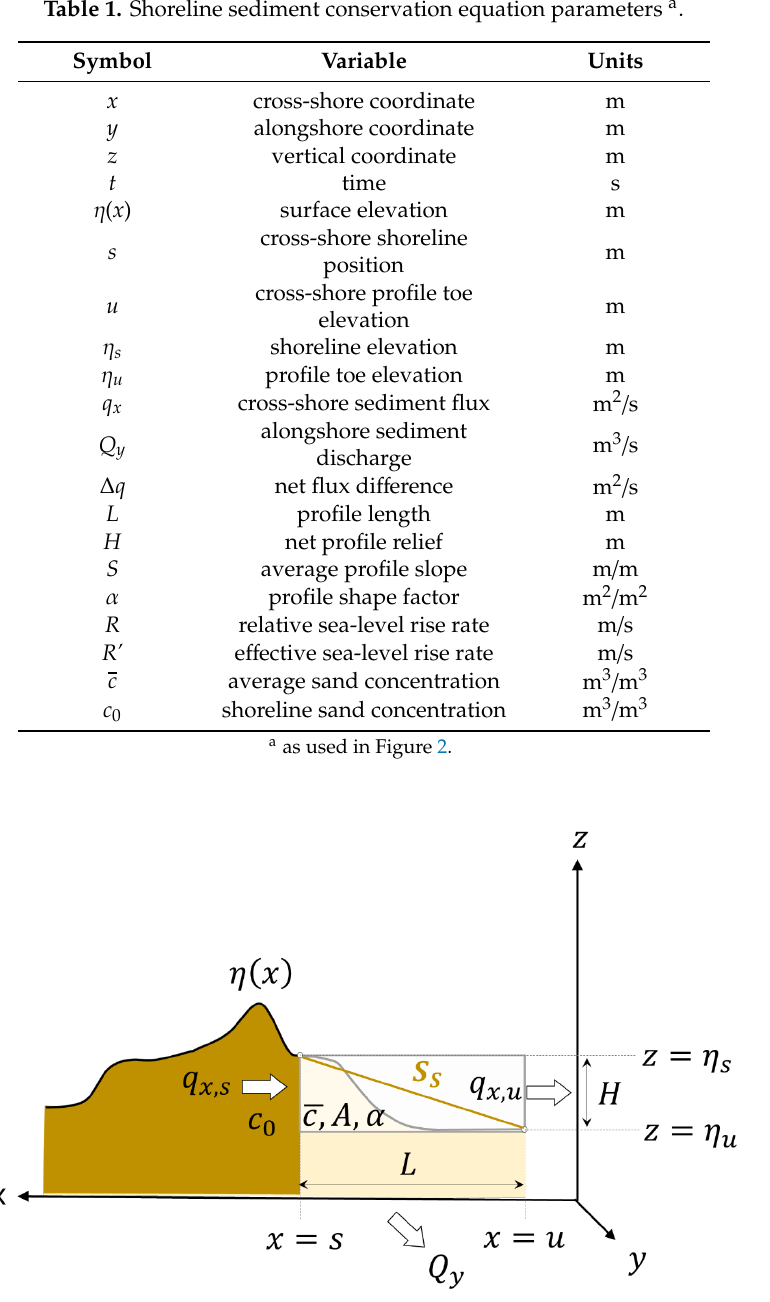
Figure 2. The shoreline response to a sea-level rise for both passive inundation and morphodynamic evolution is best understood from a general analysis of the conservation of sediments over a cross-shore profile z = η [ x ] at a fixed alongshore position y, using a shoreface control volume s ≤ x ≤ u . The sediment conservation Equation (1) assumes the control volume contains a relatively homogeneous deposit with an average sediment concentration c , but allows the possibility of a compositional change at the shoreline s , where the sediment concentration c 0 may di ff er from c . In general, c may represent bulk sediment or sediment of a particular size range. Symbols explained in Table 1. (Figure adapted by authors from